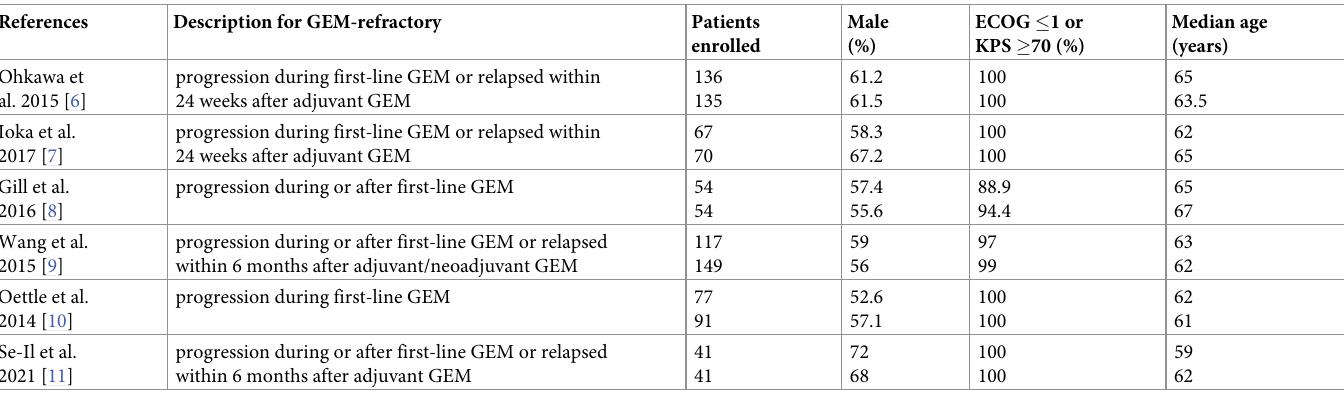
Fig 1. Flow chart for identification and inclusion of trials for this meta-analysis. https://doi.org/10.1371/journal.pone.0282360.g001 Table 2. Patients characteristics of included